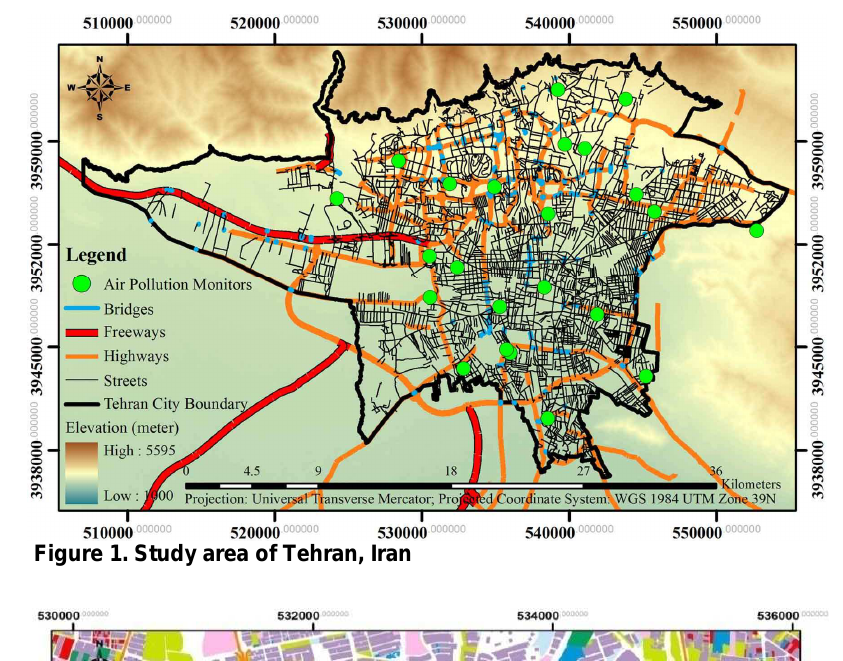
Figure 1. Study area of Tehran, Iran